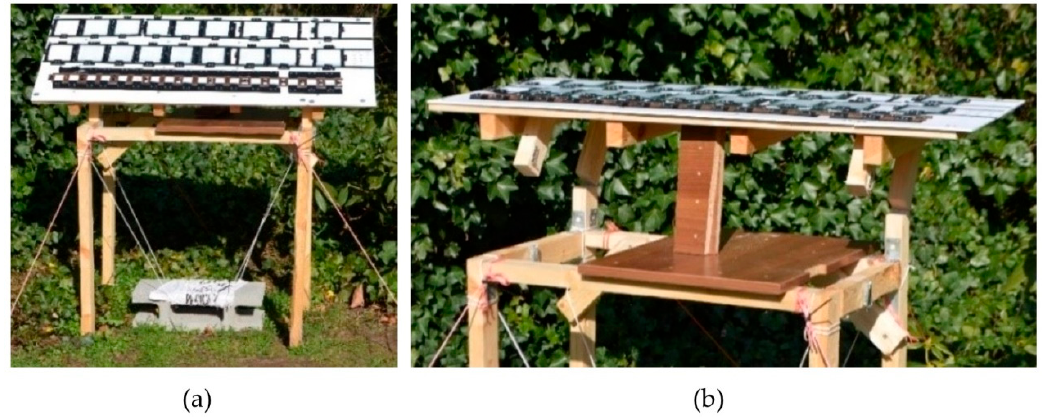
◦ tilt angle and ( b ) 0 ◦ tilt